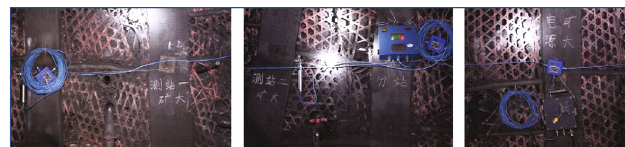
Figure 12: Borehole stress meter monitoring station.